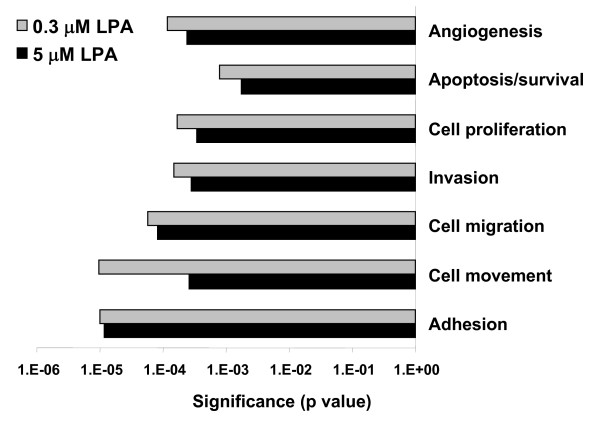
Ingenuity pathway analysis of gene expression at two different LPA concentrations. Note relative enrichment of 'cell movement' genes at the lower LPA concentration.